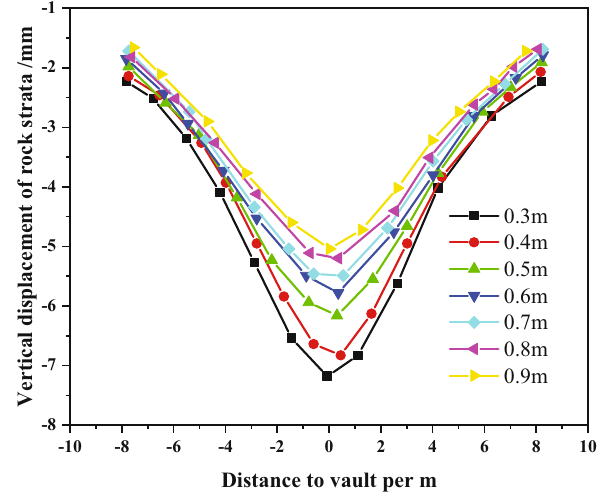
Figure 2: Vertical displacement curves of di ff erent thick rock layers.